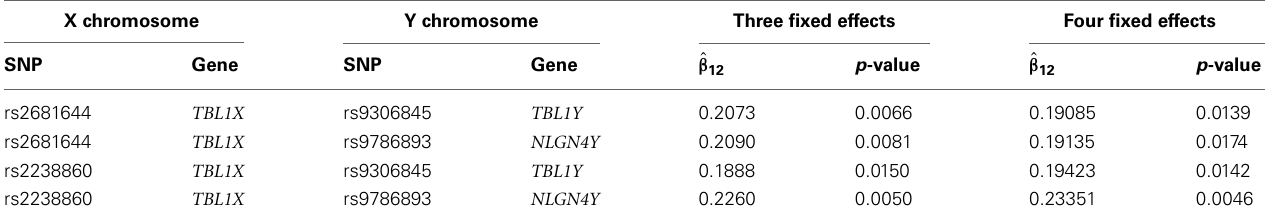
FIGURE 4 | Type I error and power of detecting interaction effects with different MAFs and four regression coefficients using an 1-1 matched logistic regression model with no population stratification. For all four β 0 = 0, coef A : β 1 = 0, β 2 = 0, and β 12 = 0 . 5, coef B : β 1 = 0 . 25, β 2 = 0 . 25, Table 5 | Two SNPs on X chromosome that show the smallest p -values. X chromosome Y